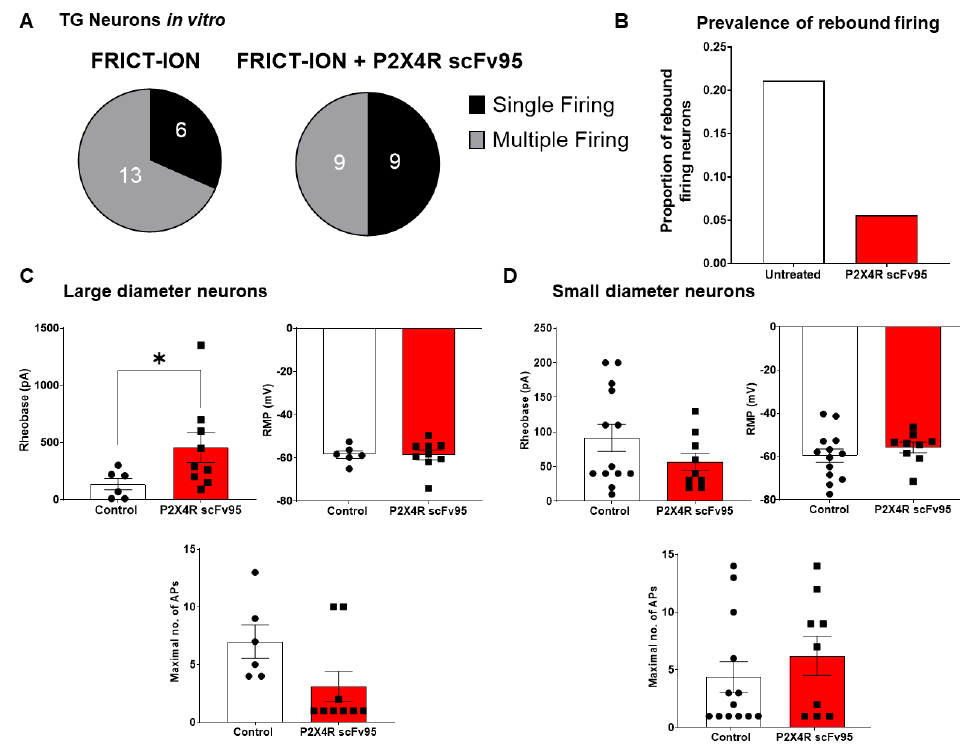
Figure 8. Effect of in vitro P2X4R scFv95 treatment on electrophysiological properties of TG neuron primary cultures from FRICT-ION mice. ( A ). Distribution of single vs. multiple action potential (AP) firing from untreated FRICT-ION and P2X4 scFv95 pre-treated FRICT-ION TG neurons. Prevalence of multiple firing was higher in untreated TG neurons from FRICT-ION mice than those with P2X4R scFv95 pre-treatment. ( B ). Prevalence of rebound firing in untreated FRICT-ION and P2X4R scFv95 pre-treated FRICT-ION TG neuronal cultures. Neurons with more rebound firing were observed more often in untreated cultures than in P2X4R-scFv-treated TG neurons from FRICT-ION mice. Effect of P2X4R-scFv treatment on electrophysiological properties of ( C ). large-diameter TG neurons (>25 microns) and ( D ). small- to medium-diameter TG-neurons (<25 microns). Untreated control n = 19 neurons, 8 mice. P2X4R scFv-treated n = 18 neurons, 5 mice. P2X4R scFv95 was used at a concentration of 4.5 µ g/ml and treatment was performed for 1–2 h in the culture media. RMP = resting membrane potential. AP = action potential.